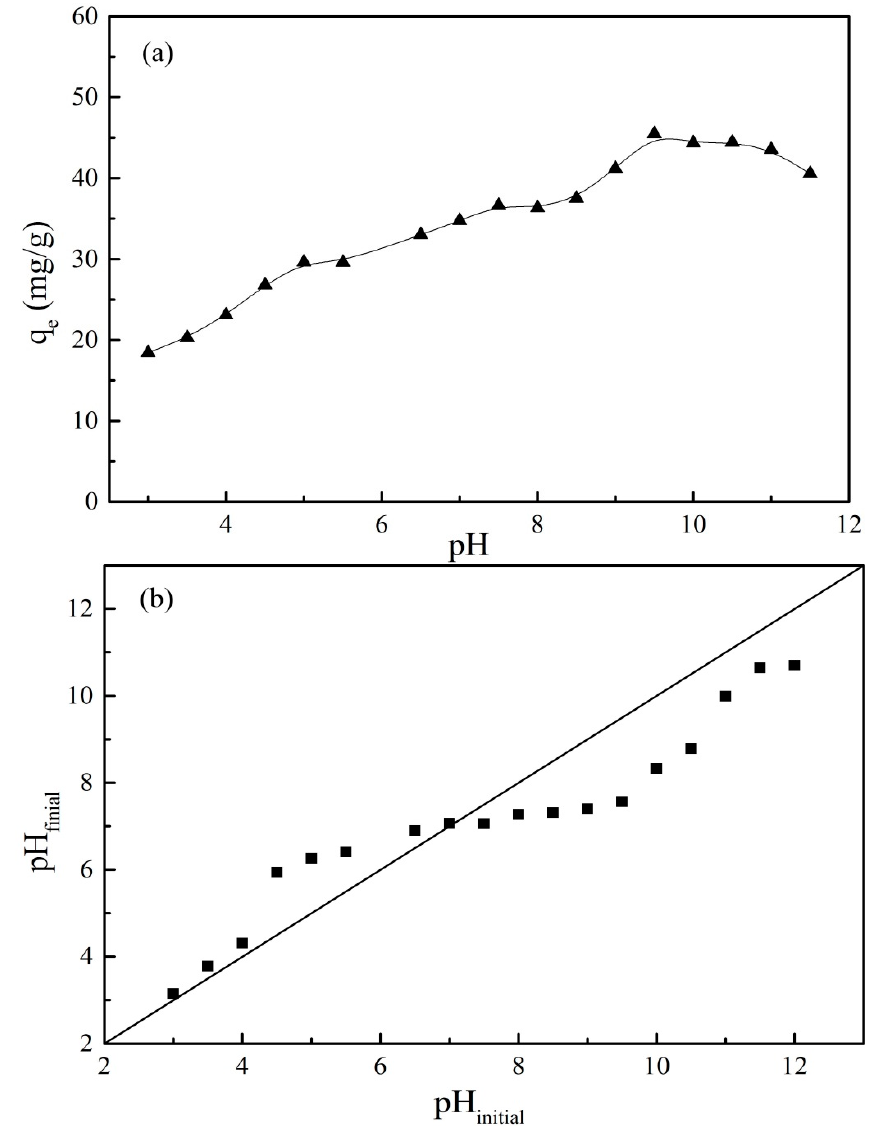
Figure 10. ( a ) Effect of pH on the adsorption of PRO onto GO/Fe 3 O 4 , and ( b ) the variation tendency of pH after the adsorption equilibrium was reached ( C 0 = 25 mg/L, V = 20 mL, m = 0.01 g, t = 24